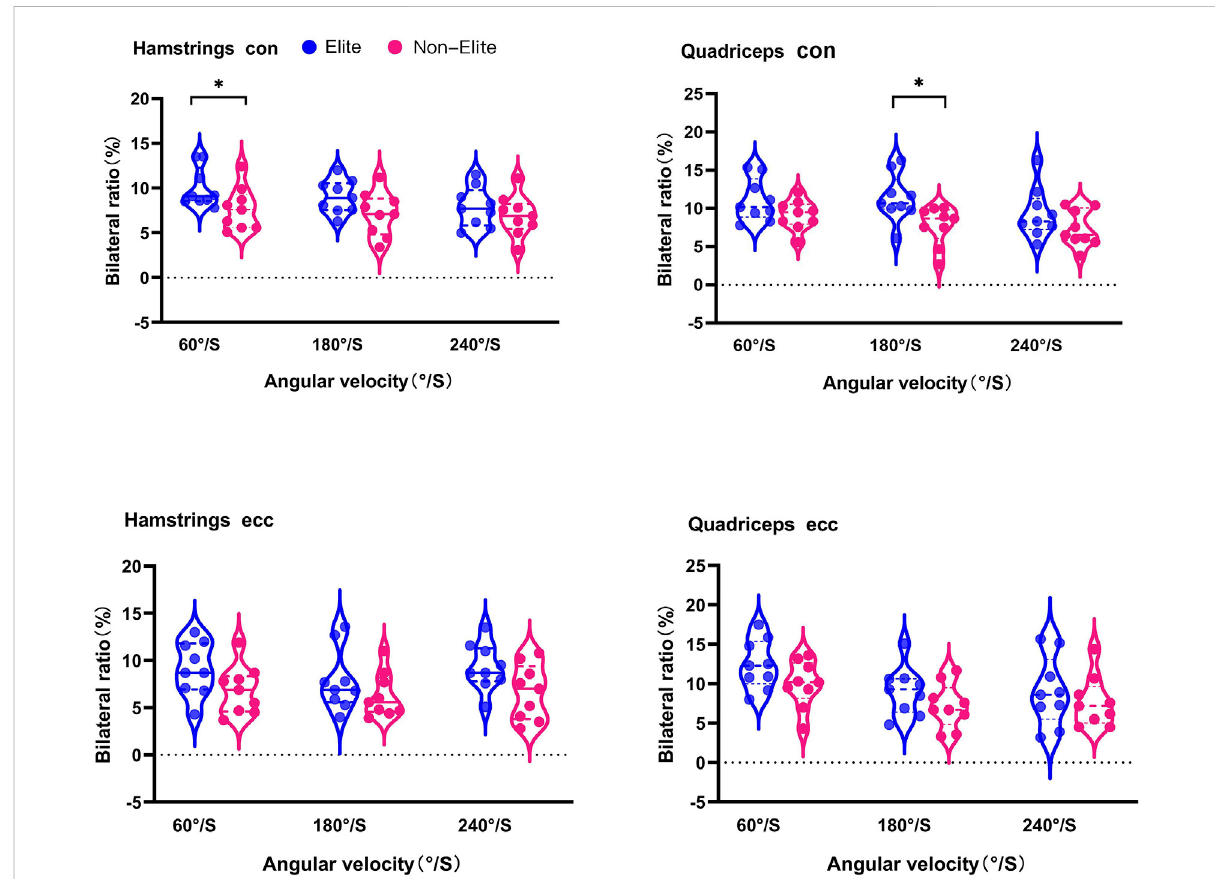
FIGURE 3 Bilateral ratio of hamstring (H) and quadriceps (Q) of the knee against 60 ° /S, 180 ° /S, and 240 ° /S in boxers. Differences between elite and non- elite groups were presented as * p <